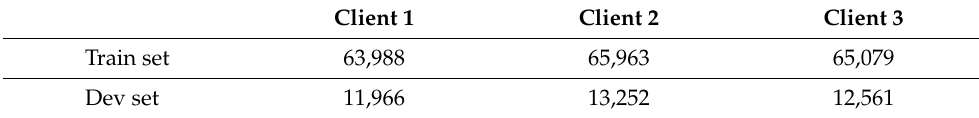
Table 1. Private train and development splits for clients on the BHI dataset